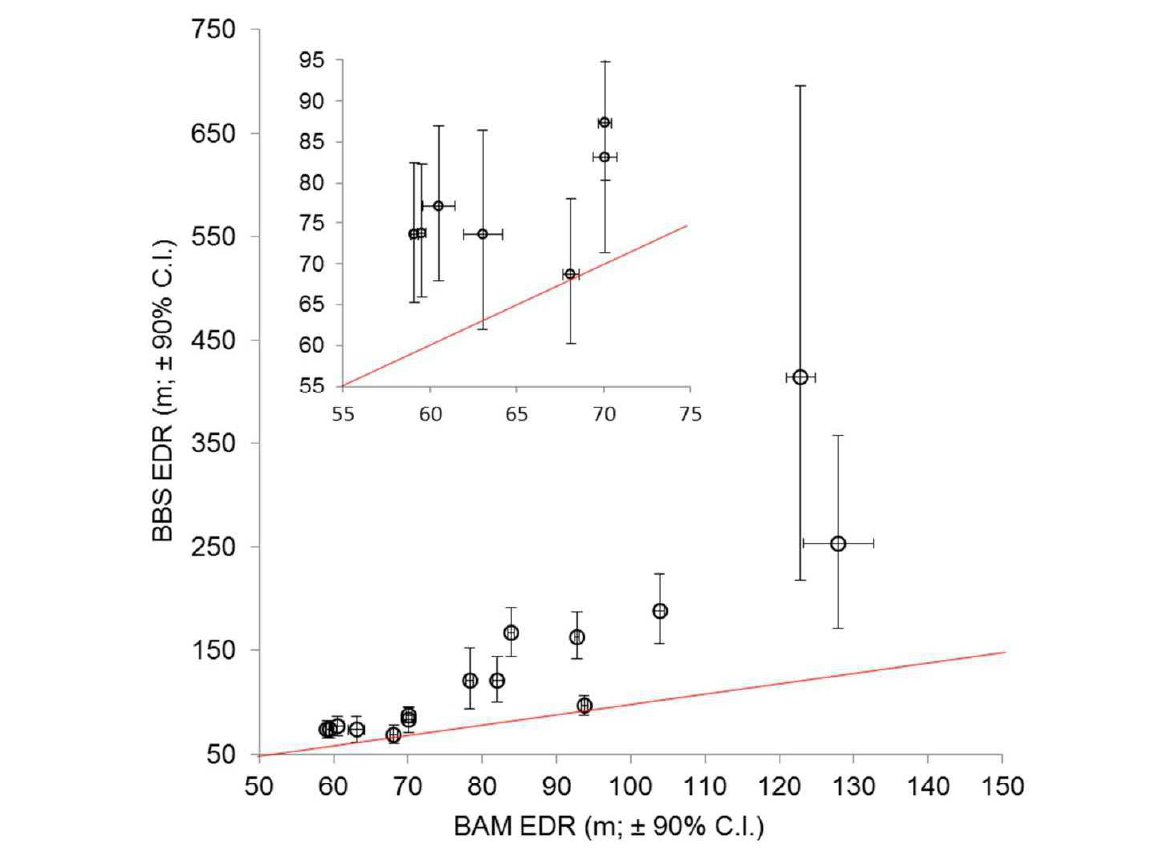
Figure A1.2. Relationship between on-road human BBS and BAM EDR estimates (± 90% C.I.) for the 15 forest birds most often detected in this study. Inset graph enlarges clustered area while red line depicts slope of 1 (note that the difference in scales between both axes was to effectively report confidence